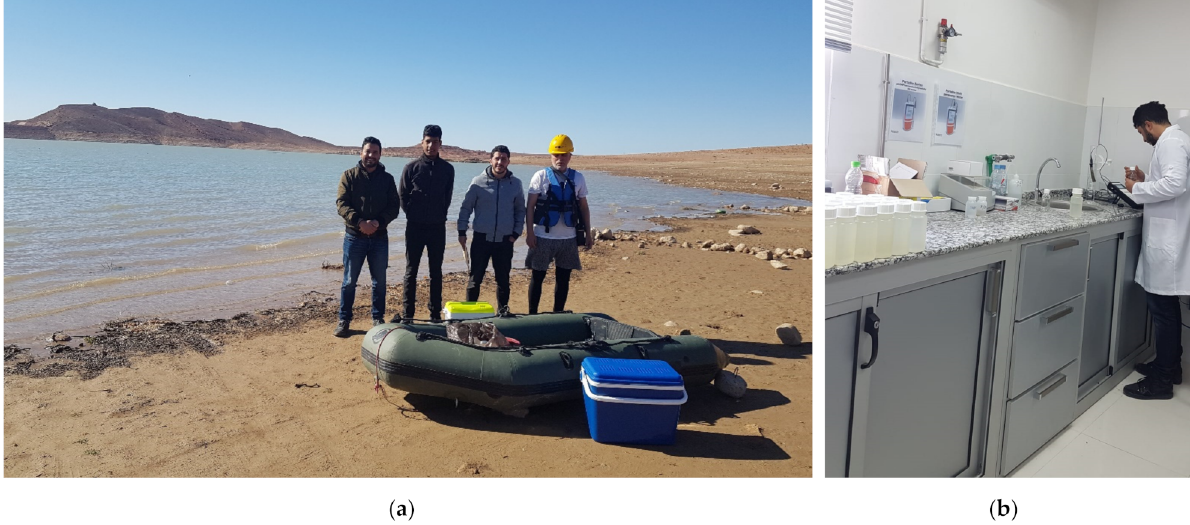
Figure 1. In situ measurement and monitoring of the Hassan Addakhil dam with ( a ) fieldwork data collection equipment and ( b ) laboratory data